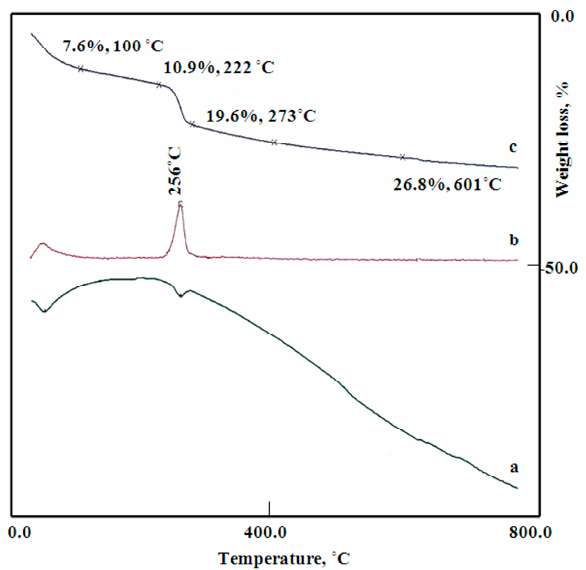
Figure 5. Thermal analyses of Co–Si LDHs (a) Differential Thermal Analysis; DTA, (b) Differential Thermal gravimetric; DTG, and (c) Thermal gravimetric; TG.